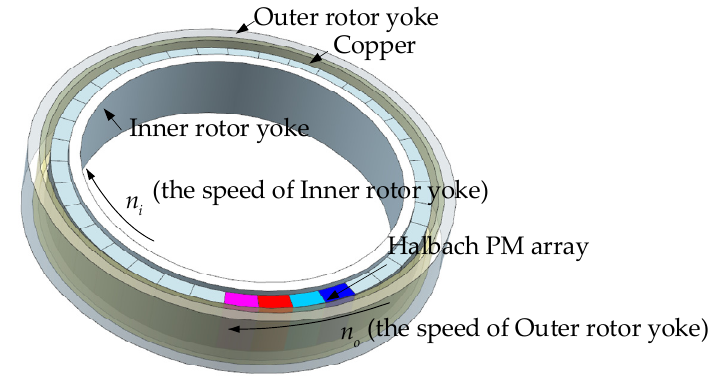
Figure 1. Three-dimensional view of an ECC with Halbach magnet array. Figure 2a,b show a cylindrical ECC’s circumferential and axial cutaways with a three-segment Halbach permanent magnet. The Halbach arrays are distributed along the circumferential direction. The copper is a little longer than the PMs for higher PM utilization rates in the axial